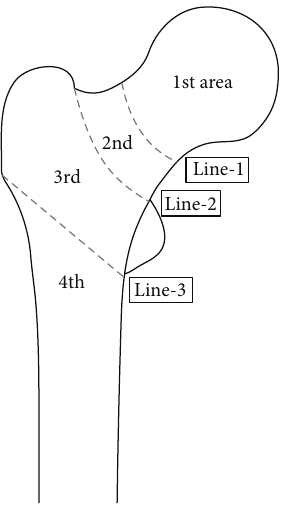
Figure 1: The boundary lines that separate areas in “area classifica- tion.” In “area classification,” the proximal femur is divided into 4 areas with 3 boundary lines; Line-1 is the center of the neck, Line-2 is the border between the neck and the trochanteric zone, and Line- 3 is the line that links the inferior borders of the greater and lesser trochanters.